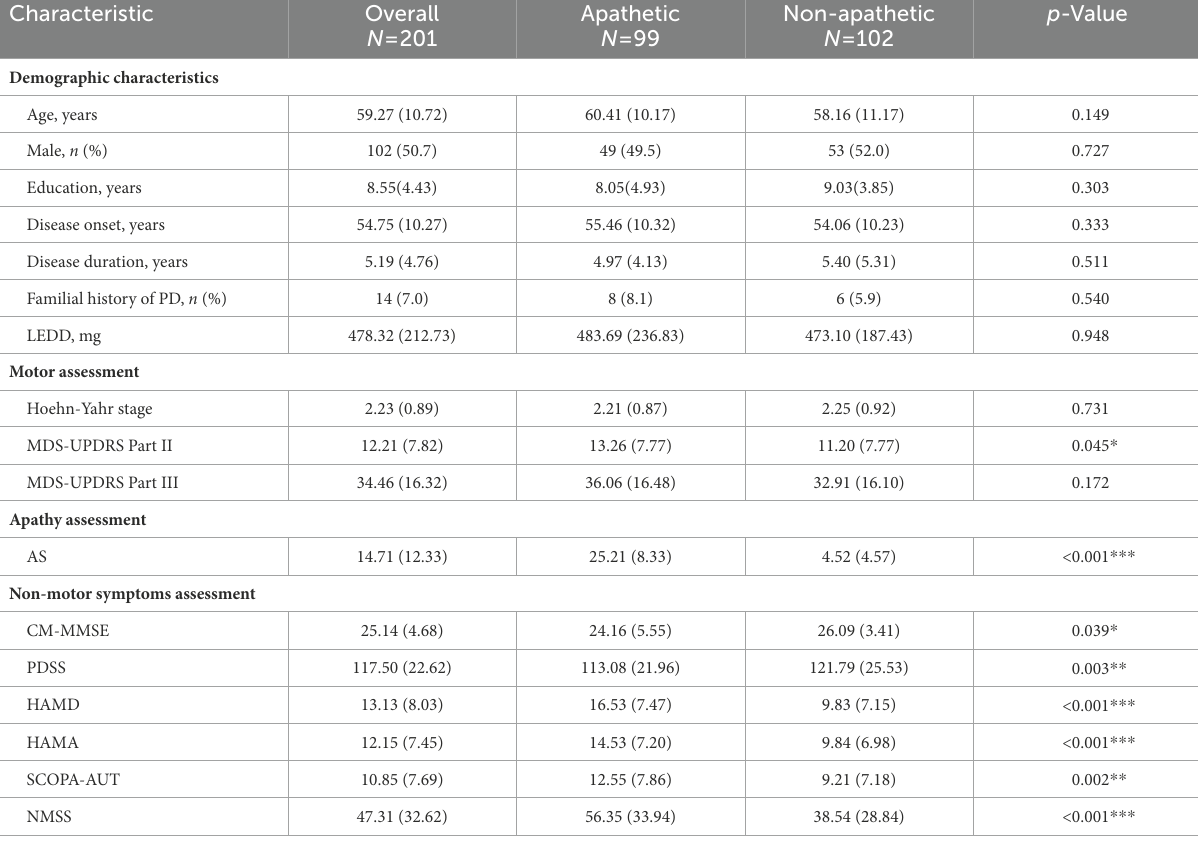
TABLE 1 Demographic and clinical characteristics of the study population.